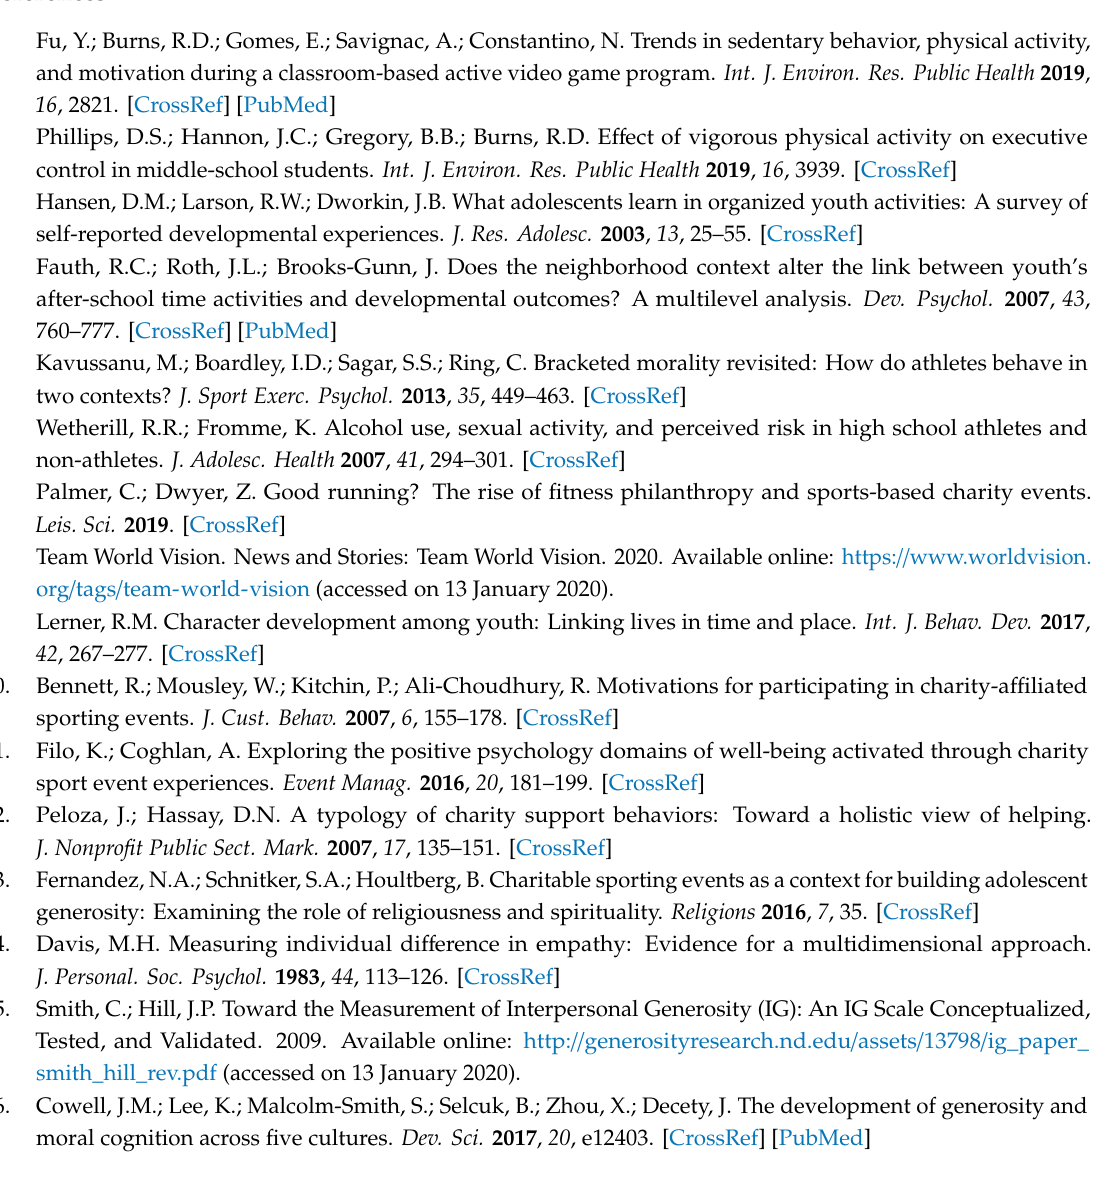
Table S1: Full results from final autoregressive models, File S1: Syntax for Autoregressive Models, File S2: Complete List of